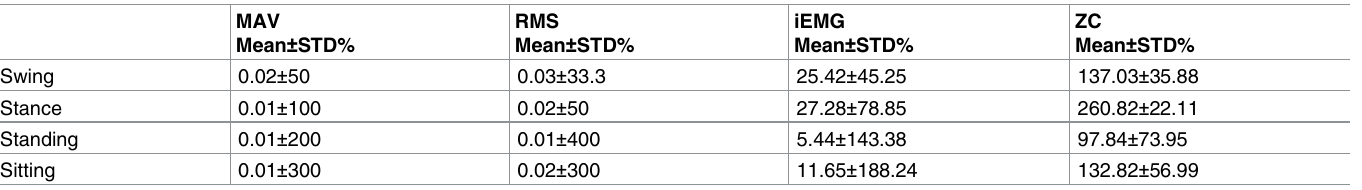
Table 1. The mean and STD for temporal features based on experimental trails from all participants on the vastus medialis muscle.